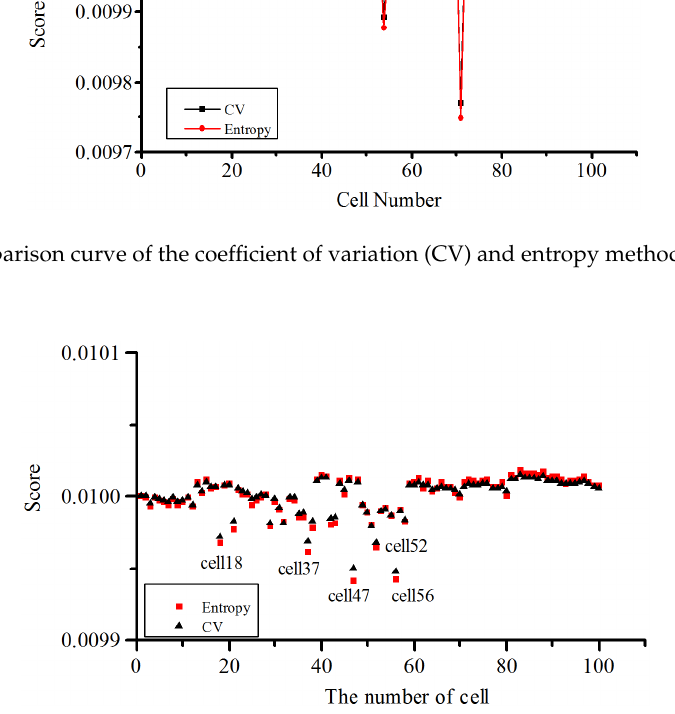
Figure 11. Comparison curve of CV and entropy method of Vehicle 1 during period 2.